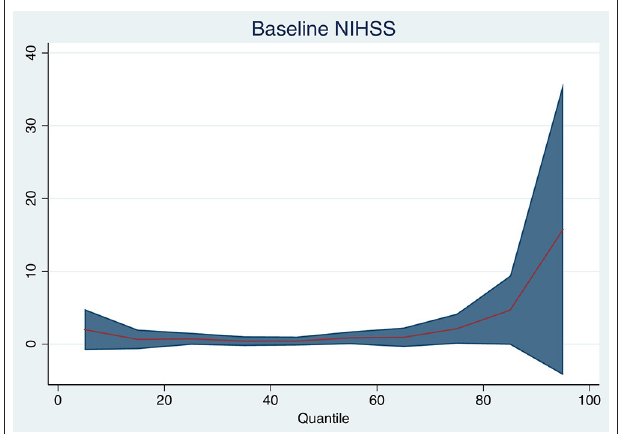
FIGURE 2 | Quantile plot shows the estimated brain volume change in milliliter and 95% confidence limits ( y -axis) according to baseline NIHSS (per point). An x -axis shows the quantile levels. Positive numbers in the y -axis reflect decrease in